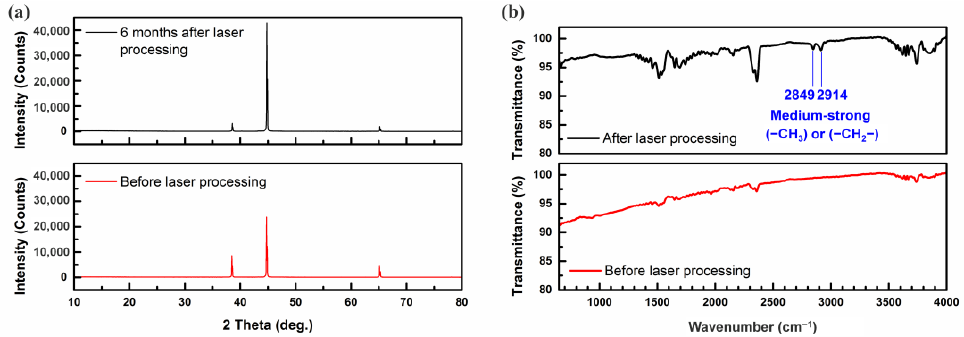
Figure 3. ( a ) The XRD result, and ( b ) the FTIR result of the aluminum surface before and after the single-shot irradiation at 192